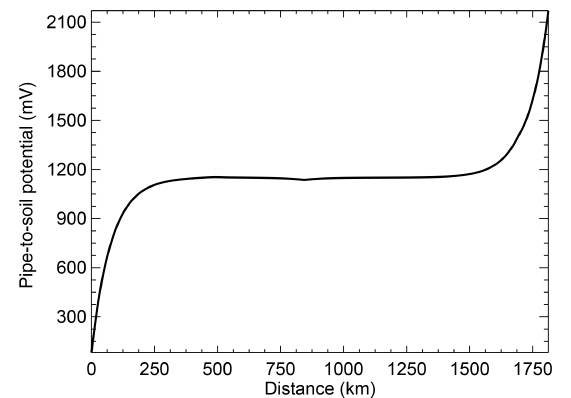
Figure 5. Pipe-to-soil potential profile as a function of the distance along the pipeline at 13:00UT on 17 March 2015.